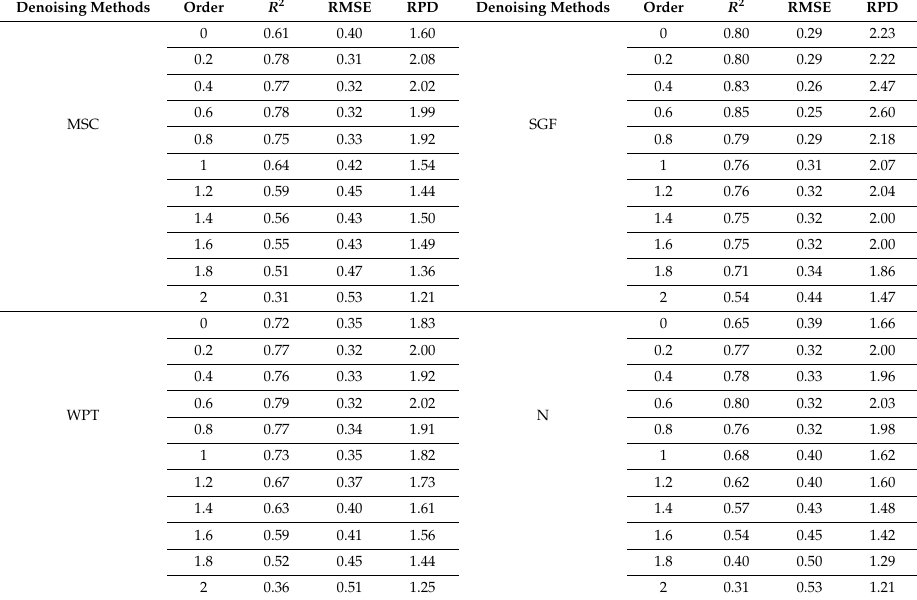
Table A1. SOM Content Estimation Model Results through PCA dimensionality reduction. DenoisingMethods Order R